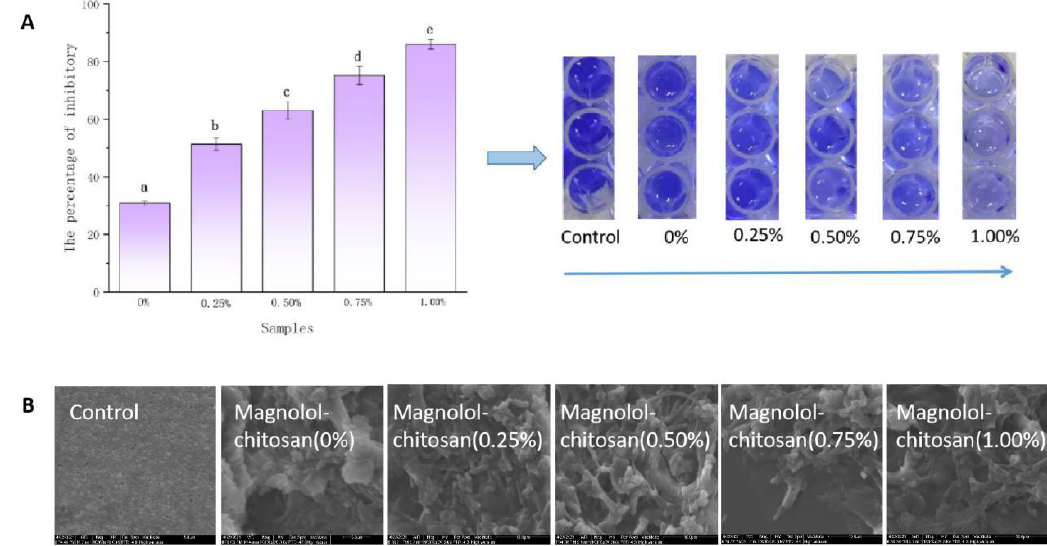
Figure 6. Antibiofilm activities of chitosan films without and with different contents of magnolol ( A ) and ESEM observation of biofilm formation ( B ). Notes: 0%, magnolol–chitosan film without magnolol. 0.25%, magnolol–chitosan film with 0.25% of magnolol. 0.50%, magnolol–chitosan film with 0.50% of magnolol. 0.75%, magnolol – chitosan film with 0.75% of magnolol. 1.00%, magnolol–chitosan film with 1.00% of magnolol.